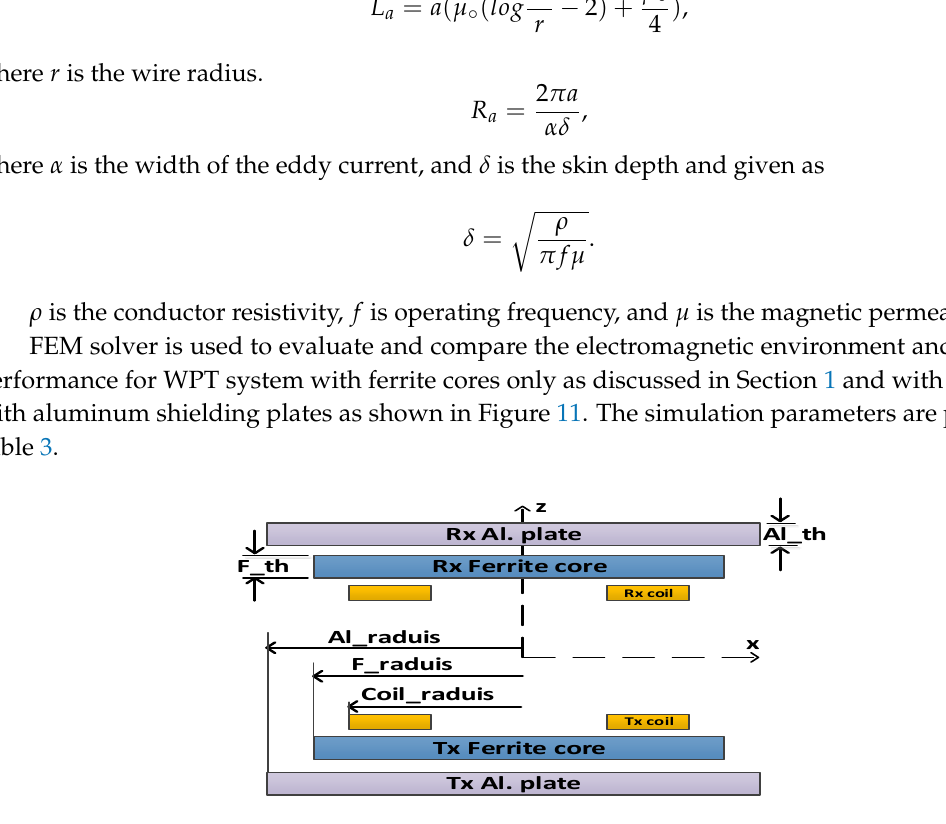
Figure 11. WPT system pad structure in the presence of ferrite cores and Al plates. Table 3. The simulation design